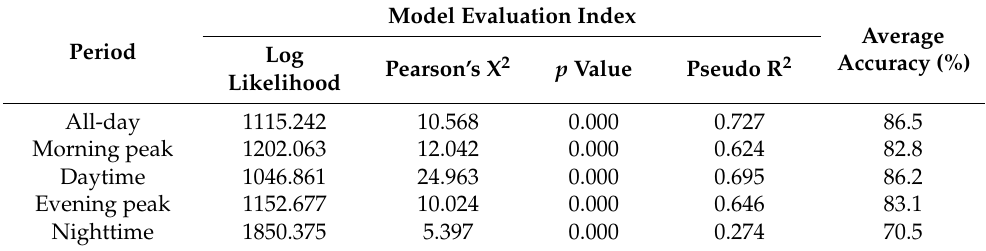
Table 4. Overall model performance